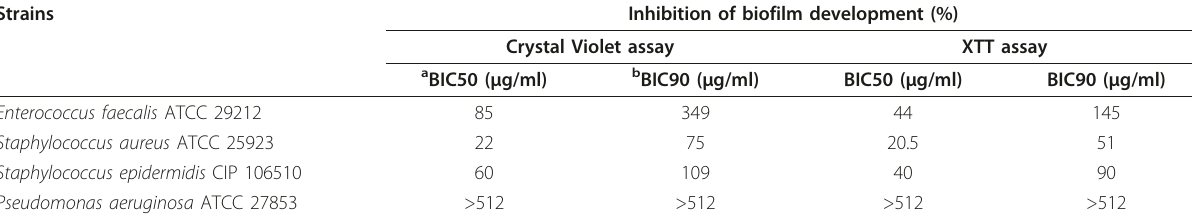
Table 2 Antibiofilm effect of thymoquinone against four positive biofilm strains